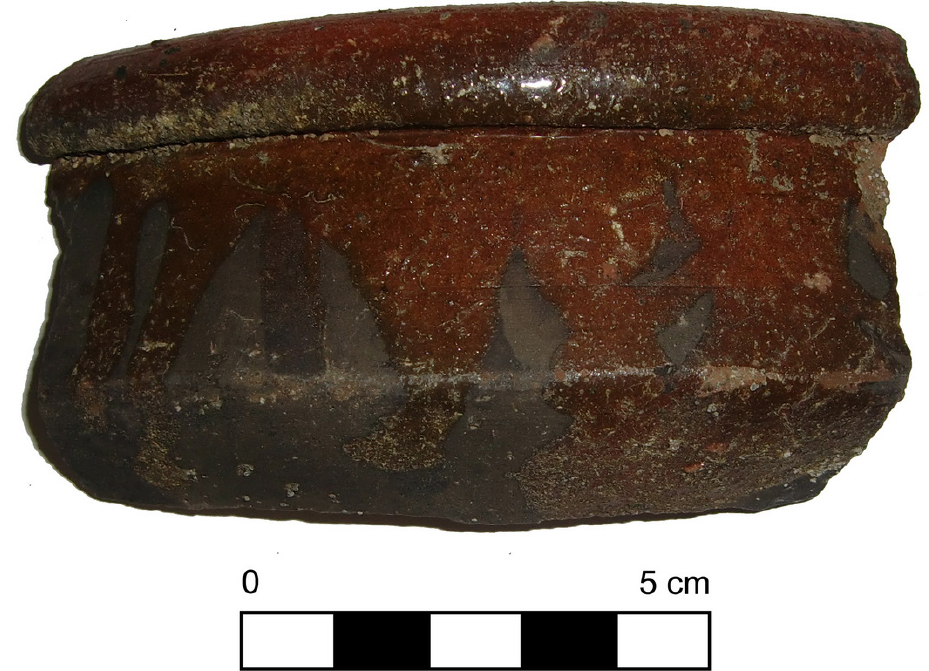
Figure 6. An edge with base wheel-made glazed pottery found during the archaeological survey at Tozal de la Mesa